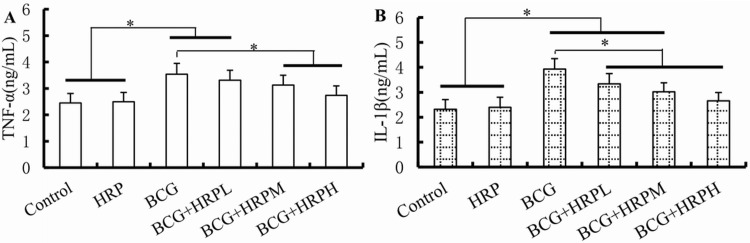
Effects of HRP on TNF-α and IL-1β content in rat liver after immune-mediated injury.Rats were treated with BCG (125 mg kg-1, intravenously, once for 2 wks) or BCG + HRP (50, 100, or 200 mg kg-1 d-1, oral administration for 13d). Each bar represents the mean ± SD of three independent experiments. n = 10/group, asterisks stars above bars indicate differences between groups.